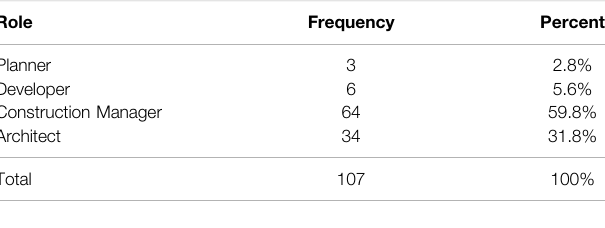
TABLE 6 | Frequency of role of respondents.